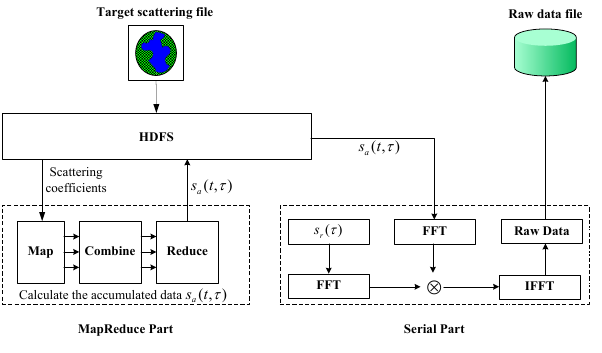
Figure 4. The cloud computing based SAR raw data simulation